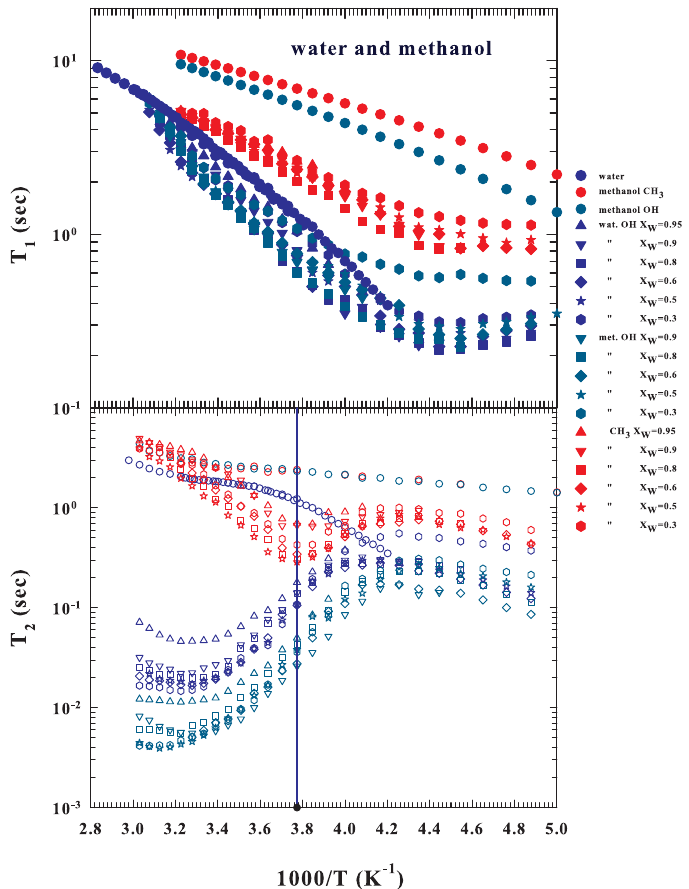
Figure 4. The Arrhenius representation of the NMR relaxation times T 1 ( top-filled symbols ) and T 2 ( bottom-empty symbols ) for water, methanol, and their solutions at the following water molar fractions: X W = 0.95,0.9,0.8,0.6,0.5 and 0.3 (the same symbol corresponds to each molar fraction). Here, we report the measured values of the hydrophilic (OH) groups of water ( blue symbols ) and methanol ( cyan ), and the methanol hydrophobic group (CH 3 , red), showing different behaviors. The vertical blue line on the bottom side indicates 265